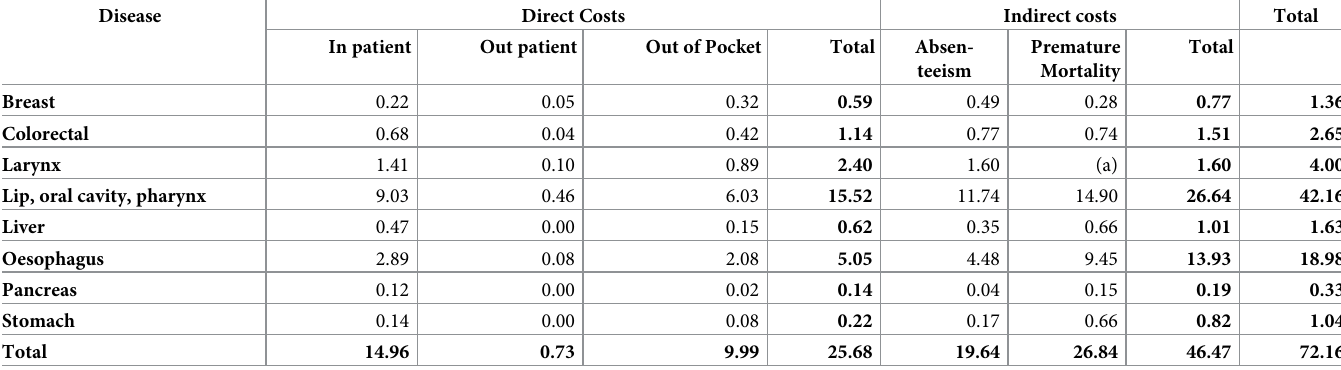
Table 3. Direct, indirect and total economic costs of alcohol related cancers in Sri Lanka 2105 in USD million. Disease Direct Costs Indirect costs